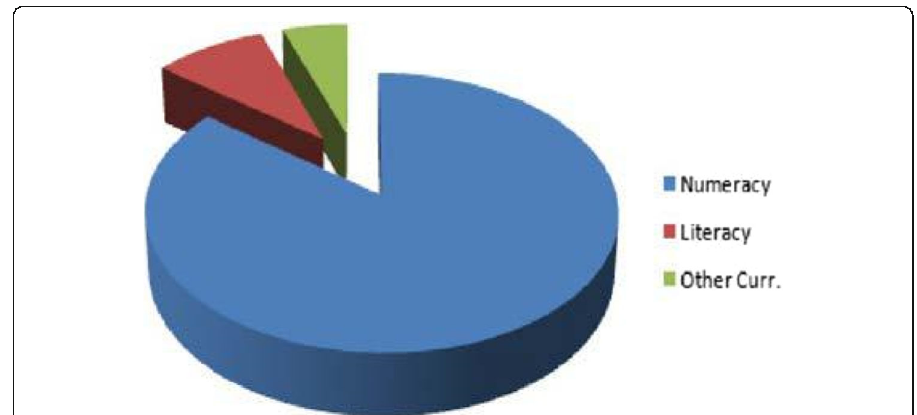
Fig. 3 Children ’ s preferred curriculum